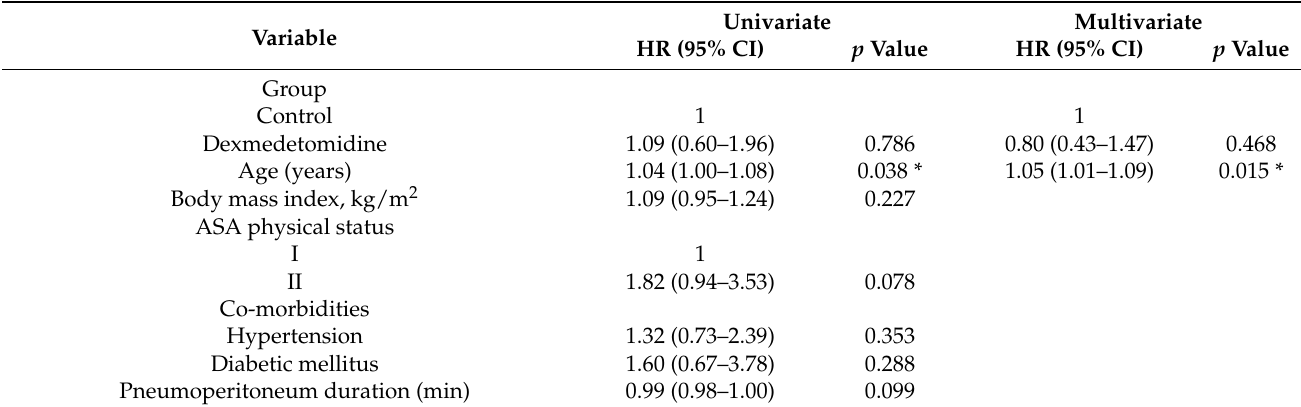
Table 3. Univariate and multivariate analyses of risk factors for biochemical recurrence after RALP ( n = 114). Variable